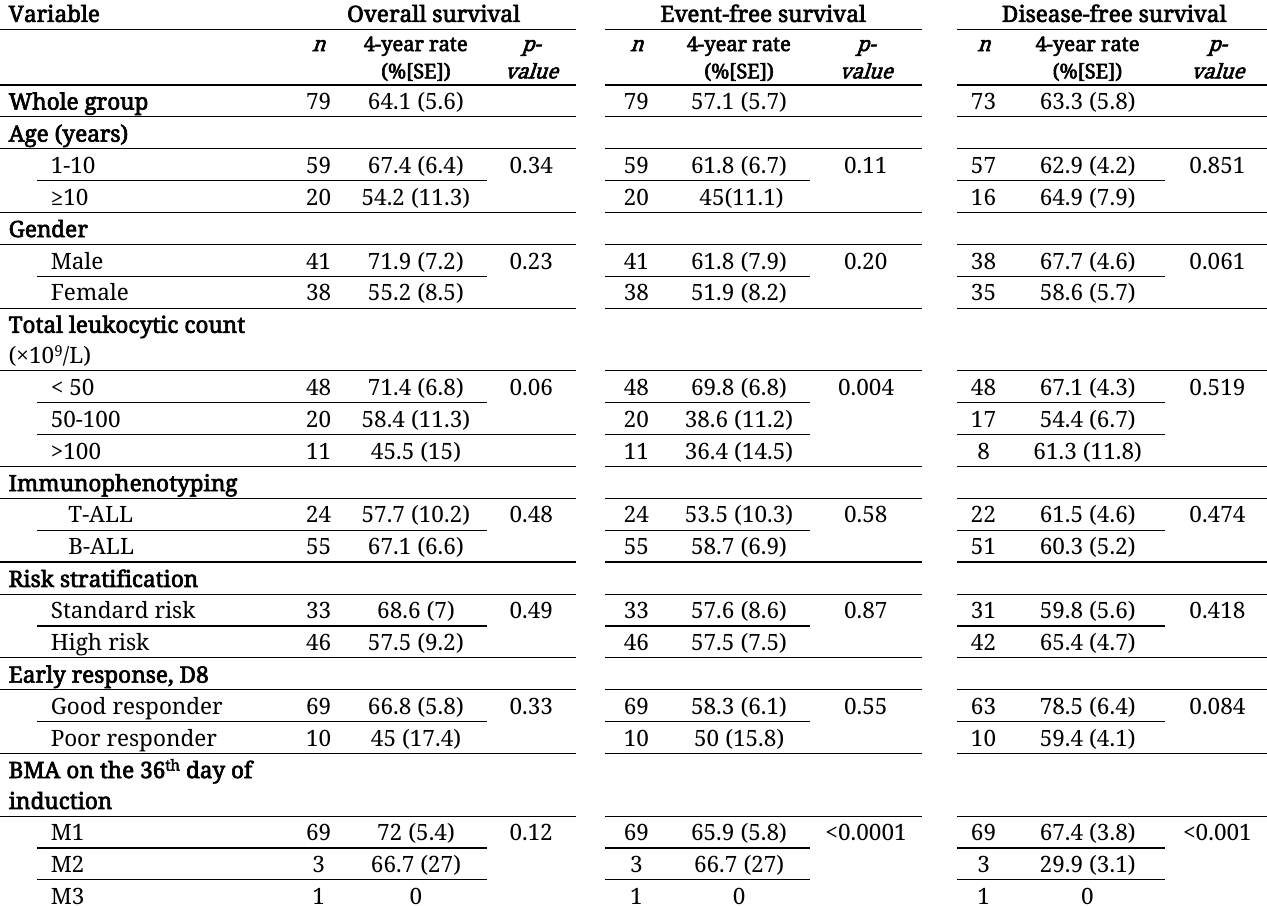
Table 2: Survival rates in relation to different risk